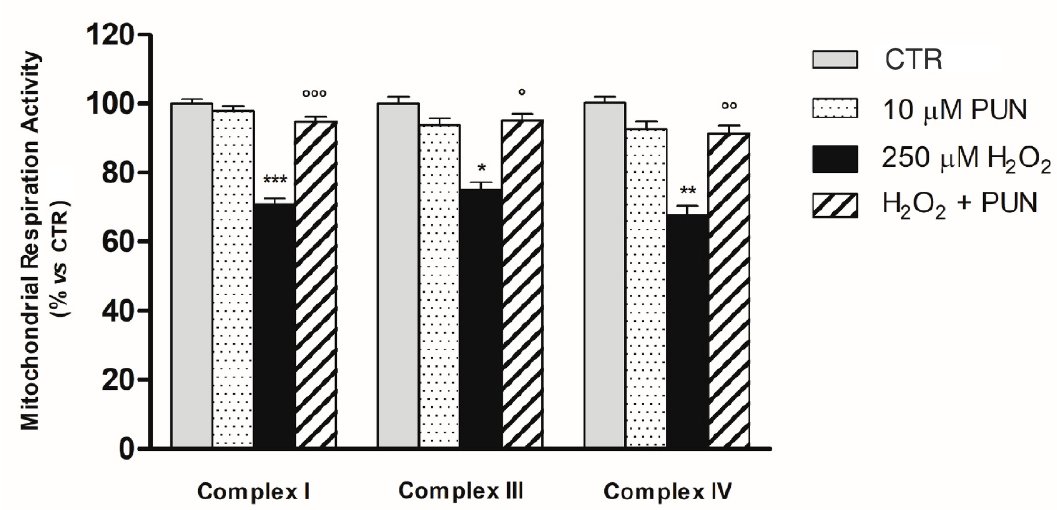
Figure 4. The activities of mitochondrial respiratory chain complexes I, III, and IV were measured in mitochondria isolated of ARPE–19 cells. Enzyme activities were determined using specific assay kits (see Section 2.6 in Material and Methods). Results are shown as percentages relative to control for the single complex, which was set at 100%. Data are presented as the mean ± SEM of six replicates per experimental group from two independent experiments. One–way ANOVA analysis was carried out followed by post hoc Newman–Keuls test for each single respiratory complex. *, p < 0.05; ** = p < 0.01 and *** = p < 0.001 vs. Control; ° = p < 0.05; °° = p < 0.01 and °°° = p < 0.001 vs. H 2 O 2 (250 µM) alone.